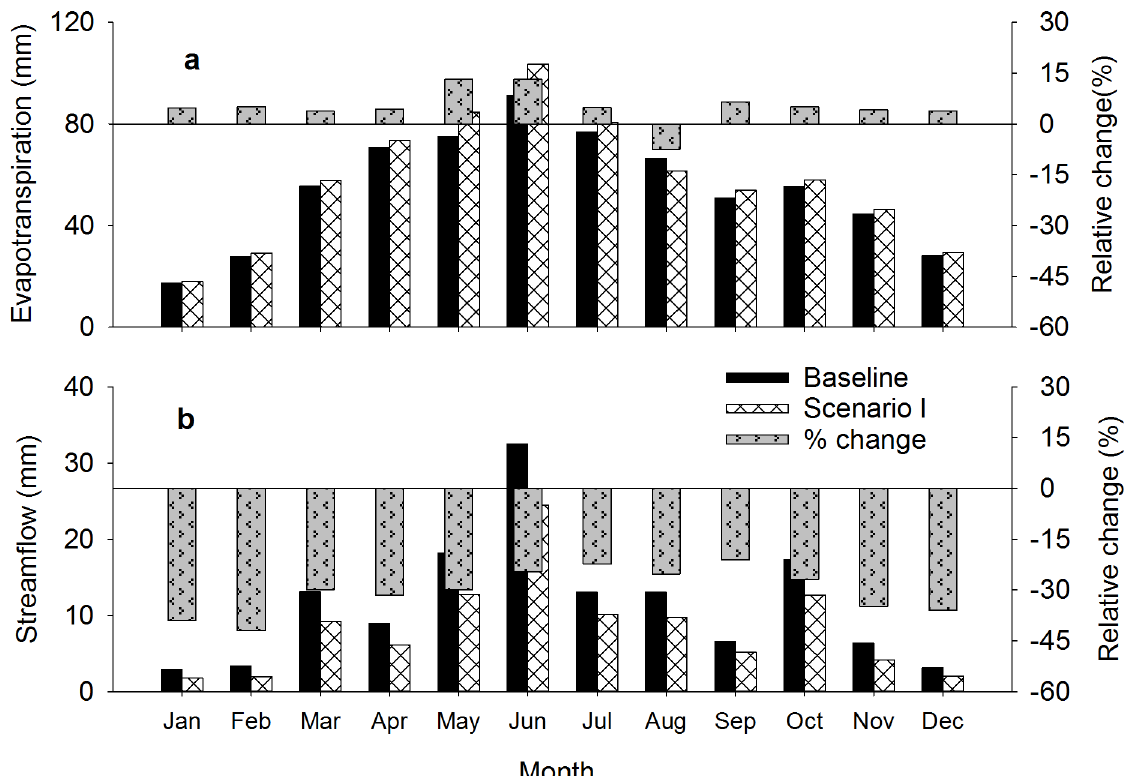
Fig 5. Simulated averagemonthly evapotranspiration(a) and streamflow (b) for 2002–2011for the baselineand scenario-I (grassland conversionto switchgrass).